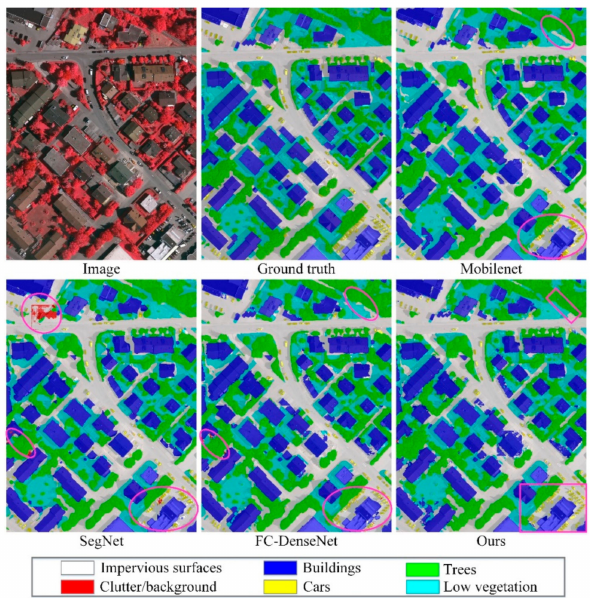
Figure 8. A full image land cover classification result on the Vaihingen dataset. The circles in pink and the rectangle in pink represent the correct and incorrect classification, respectively.